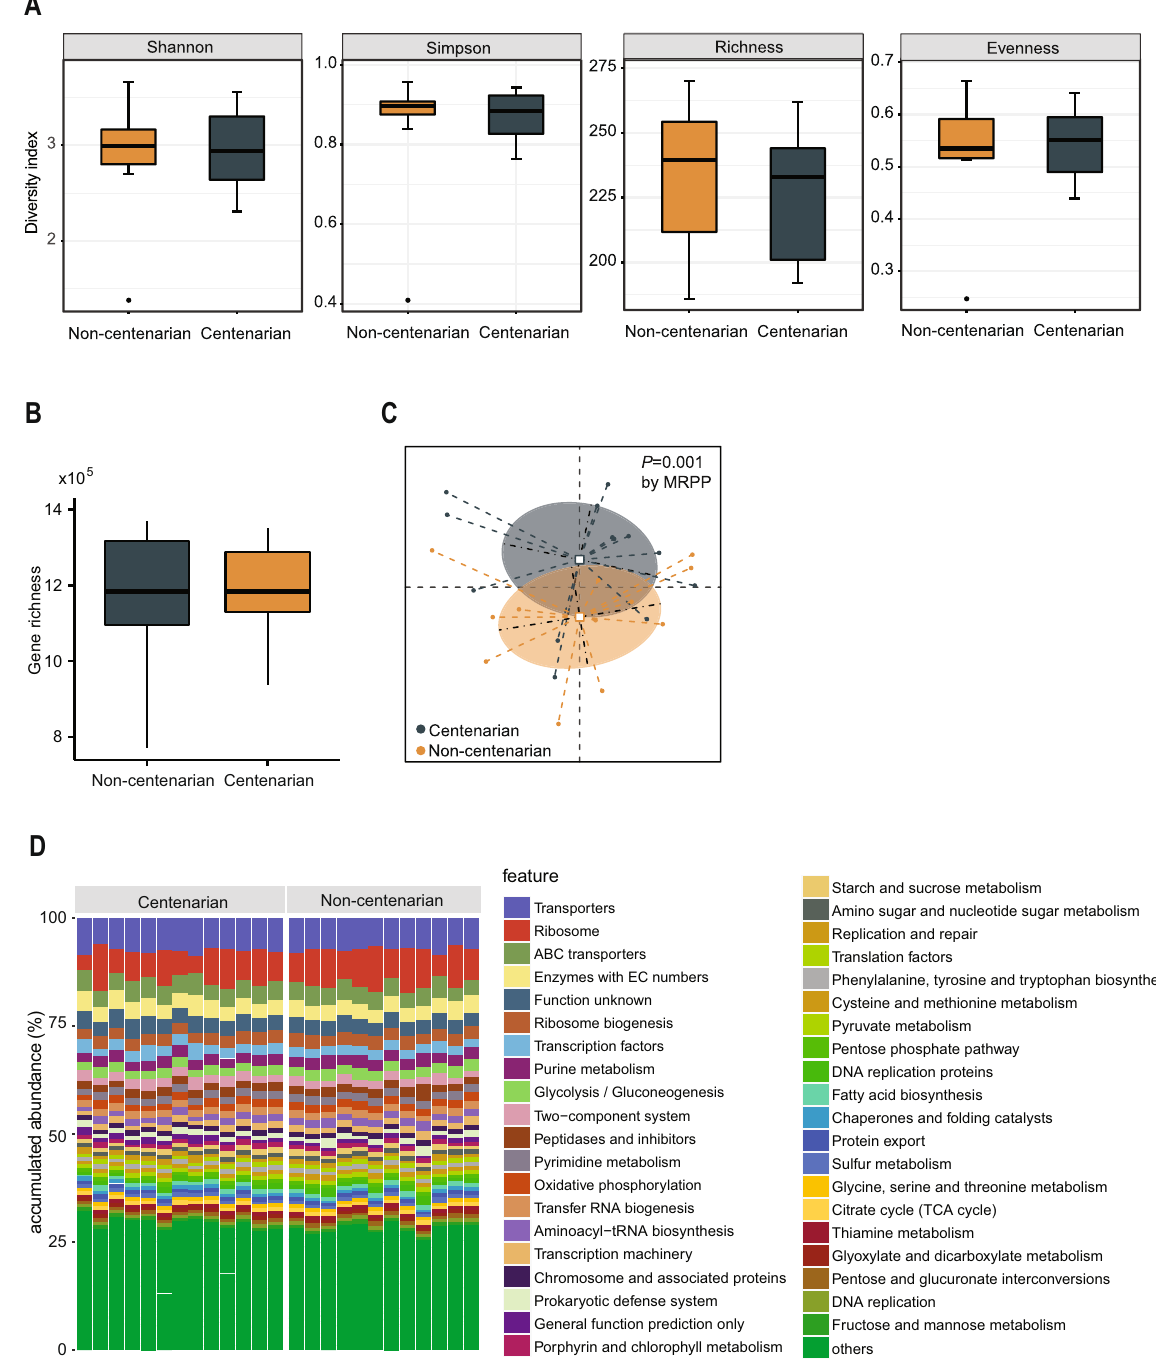
Fig. 2 There is no signi fi cant difference in the gut microbiota composition between centenarians and non-centenarians. A Alpha diversity. B Gene richness. C Principal coordinate analysis (PCoA) analysis based on the species-level microbial community. The signi fi cance was calculated by multi-response permutation procedure (MRPP) analysis. D Functional gene pro fi le. There is no signi fi cant difference between the two